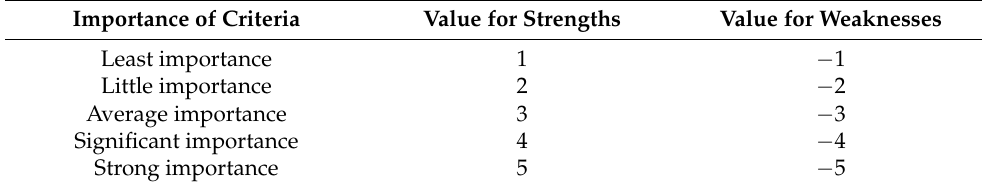
Table 4. Importance of criteria (Source: Own Elaboration, 2019).